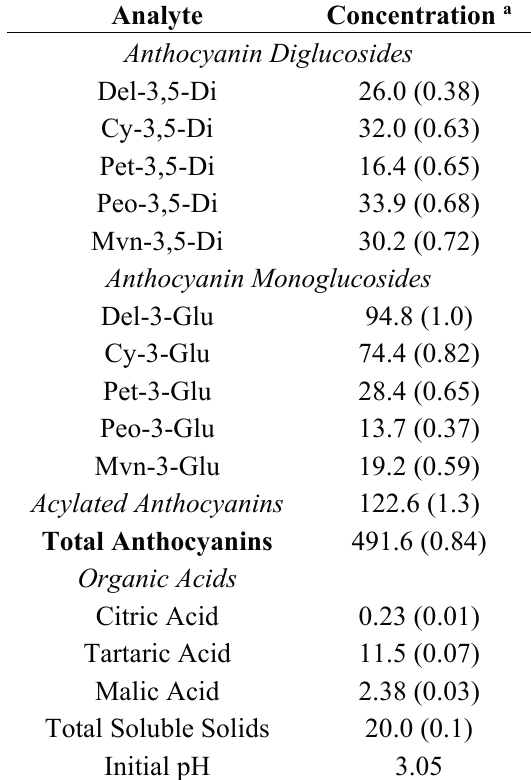
Table 1. Initial anthocyanin concentrations and basic juice parameters in Concord juice.